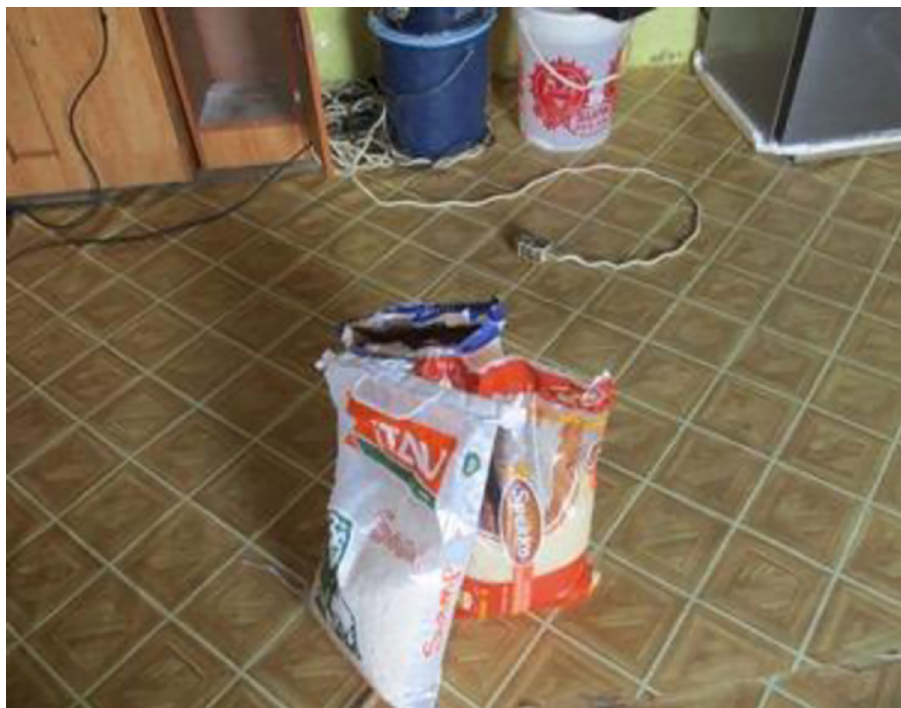
Fig 8. Image from co researcher